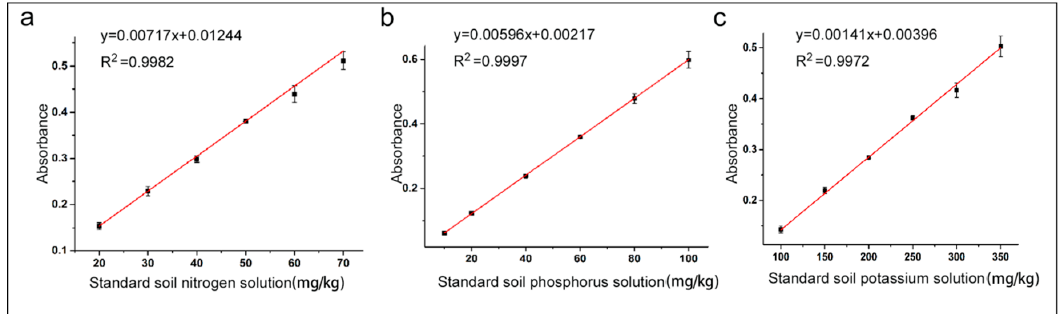
Figure 4. Calibration curves of nitrogen, phosphorus and potassium obtained from the multichannel